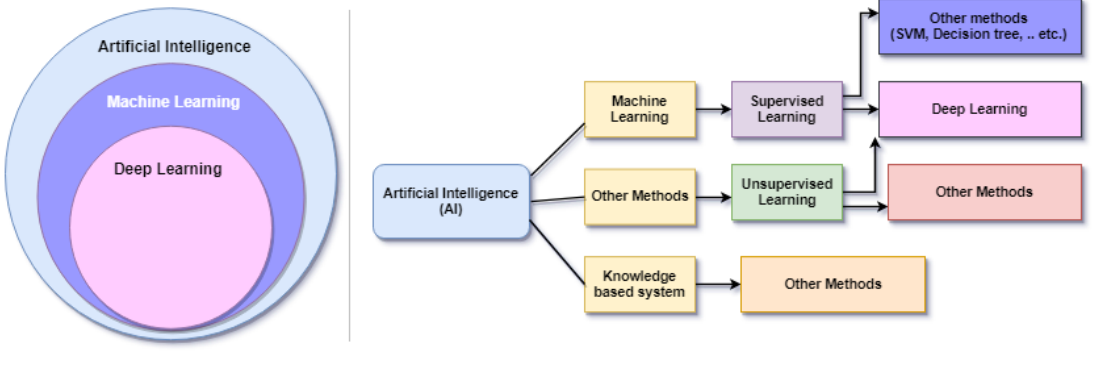
Figure 5. Overview of comparison between AI–ML–DL